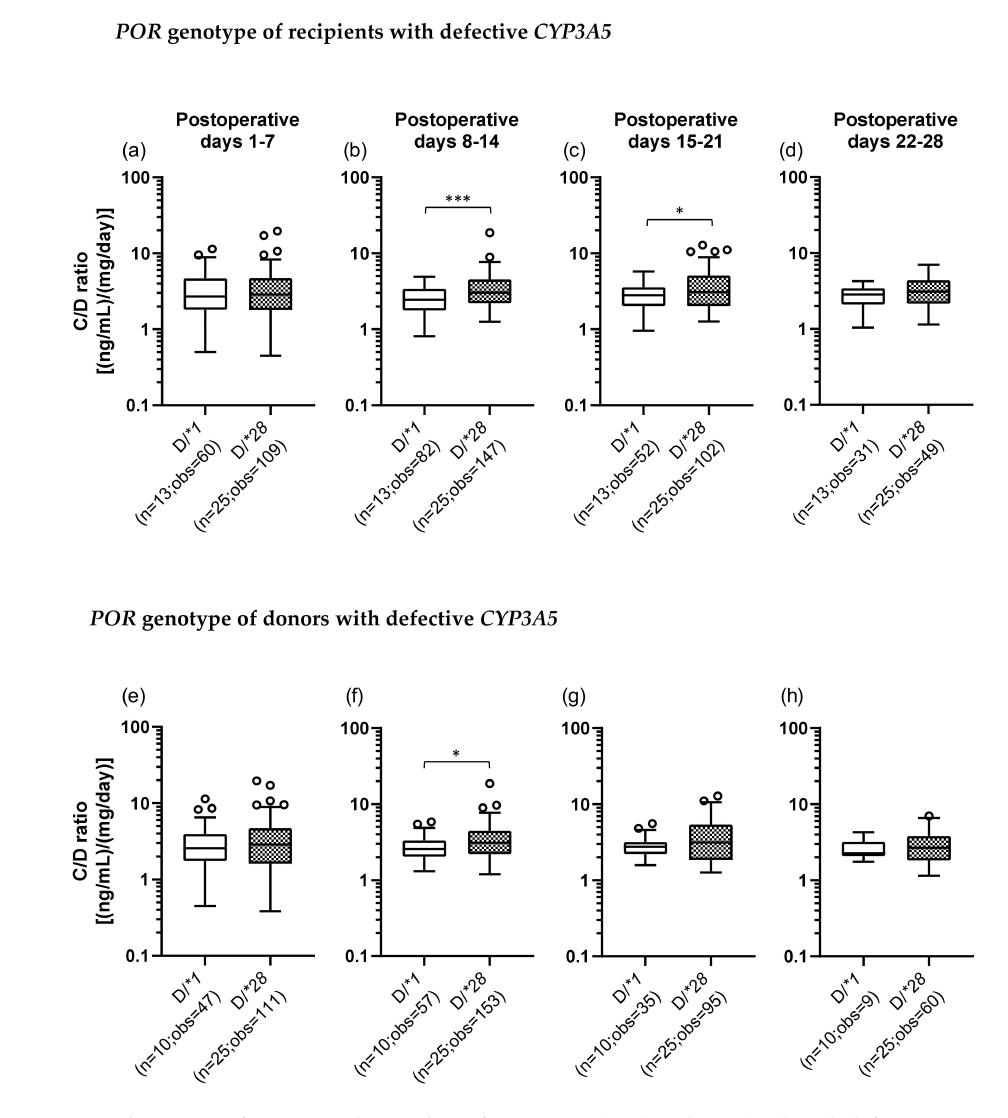
Figure 4. The impact of POR*28 polymorphism for recipient ( a – d ) or donor ( e – h ) with defective CYP3A5 on the C / D ratio of tacrolimus for postoperative days 1–28 after living-donor liver transplantation. The C / D ratios of tacrolimus for 1–7 (a, e), 8–14 (b, f), 15–21 (c, g) and 22–28 (d, h) days after transplantation were compared by POR polymorphism (D, defective; *1, POR*1 / *1 ; *28, POR*1 / *28 and POR*28 / *28 ). The bar indicates the median tacrolimus C / D ratio for each group and boxes represent the 25th and 75th percentiles of the data. The whiskers represent the lowest and highest values that fall within 1.5 times the interquartile range of the lower quartile and the upper quartile, respectively. *p < 0.05 and *** p < 0.001, between groups. n, number of patients; obs, number of observations i.e., number of tacrolimus